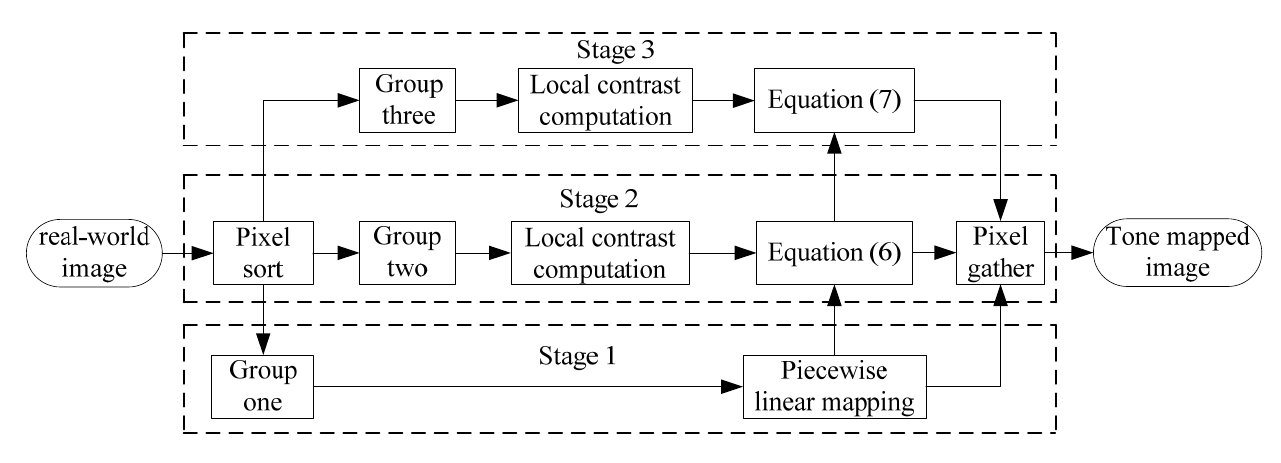
Figure 4. The flowchart of the three ‐ stage algorithm.